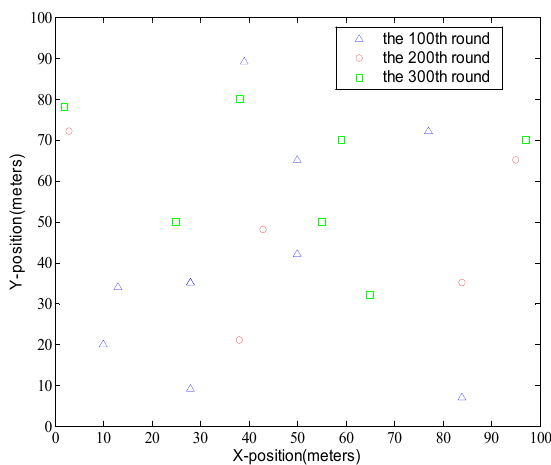
Figure 7. The distribution of cluster heads in WHRA-KF